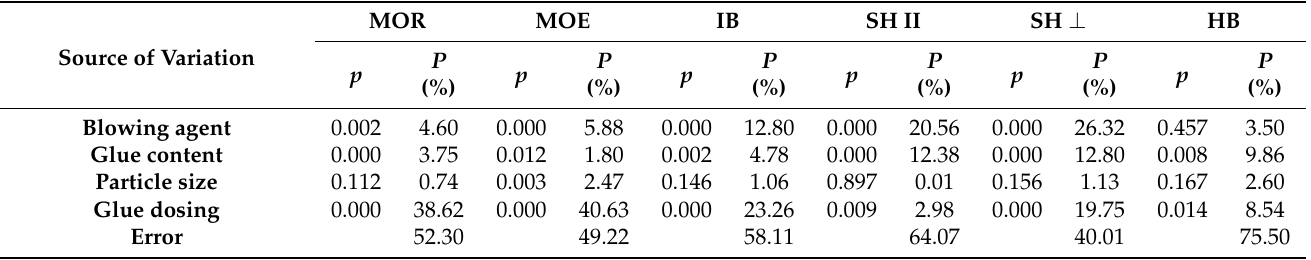
Table 2. ANOVA for selected factors affecting MOR, MOE, IB, SH, and HB of manufactured particle- boards ( p —probability of non-significant effects, P —percentage influence).